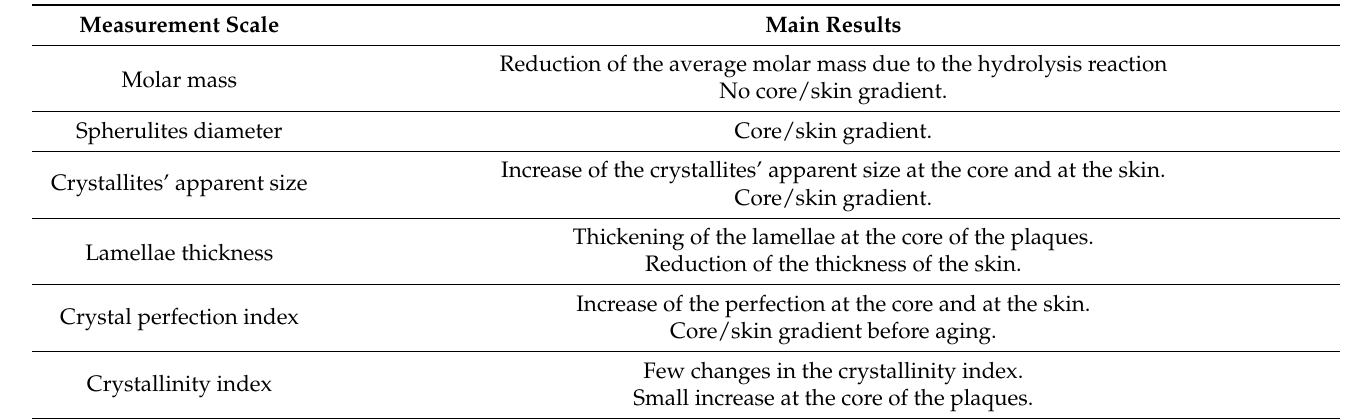
Figure 12. Influence of the ageing conditions on the crystallinity index at the core and the skin of the PA66 plaques. Table 1. Summary of the microstructural changes occurring in an injection molded PA66 during thermo-hydro-glycol